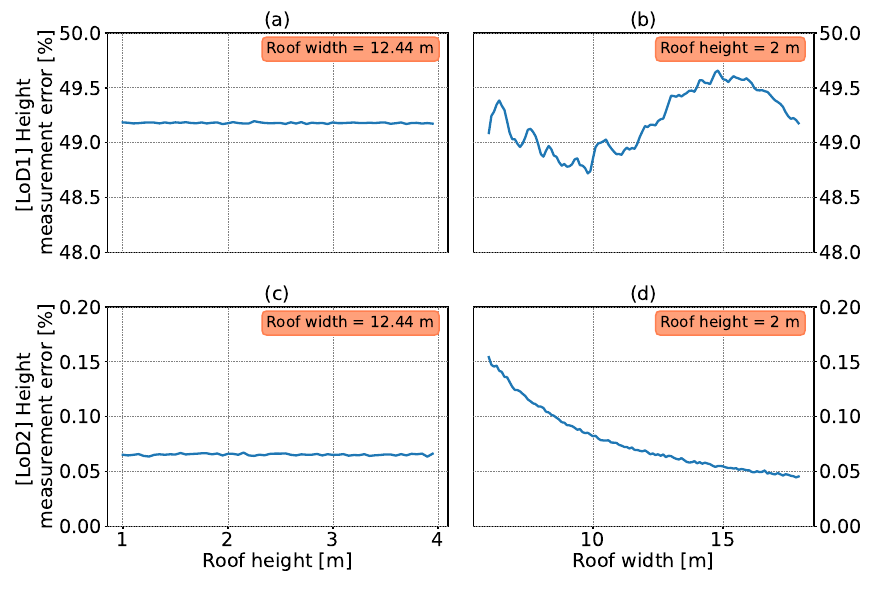
Figure 4. Mean measurement error (MME) for LoD1 and LoD2 measurements as a function of roof height and roof width.